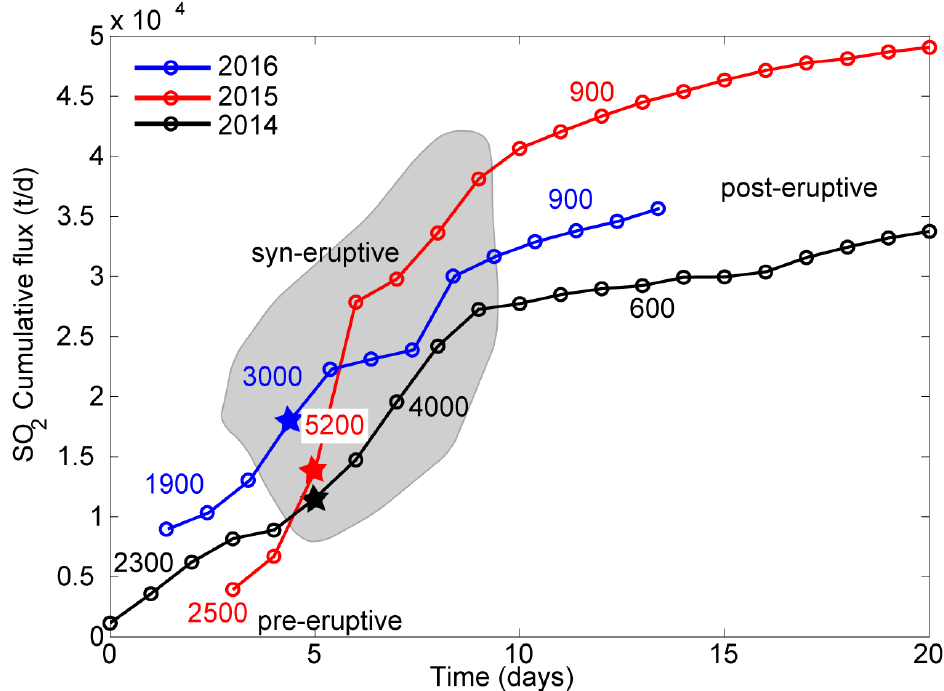
Figure 10. Comparison between cumulative SO 2 flux trends associated with three lava fountaining paroxysmal sequences that occurred at NSEC (black line) in August 2014, and at VOR in December 2015 and May 2016 (red line and blue line). Stars indicate onsets of the paroxysmal sequence. Pre-eruptive, syn-eruptive, and post-eruptive phases show similar SO 2 fluxes for all these three events. In each of these three events, pre-eruptive fluxes range between 1900 and 2500 t/d, syn-eruptive fluxes are the highest (3000 – 5200 t/d), while post-eruptive fluxes are systematically the lowest (<900 t/d).